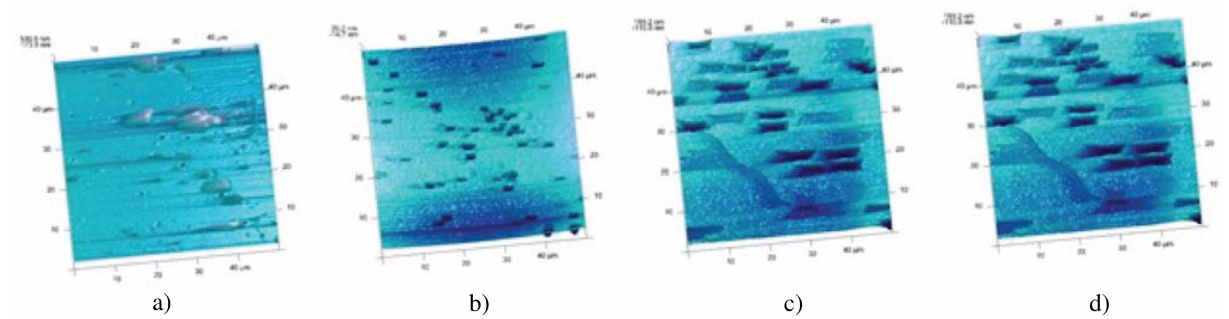
Figure 7: Surface topography of the face 011 of the large crystals exposed to the dissolution media recorded at time points 0 (a), 1 h (b), 3 h (c), 6 h (d) respectively at 500× magnification